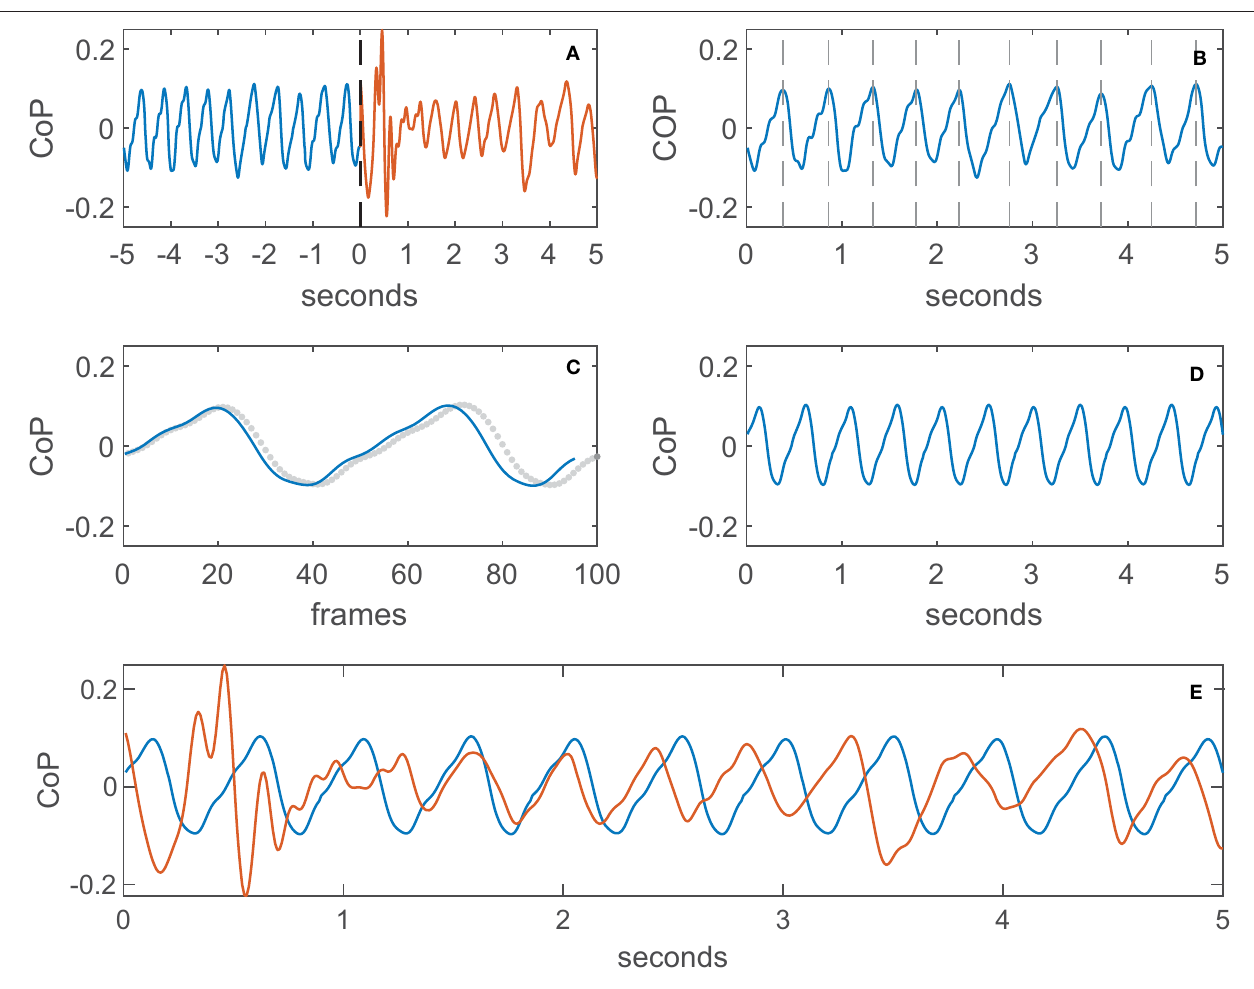
FIGURE 2 | Example calculation of the QRP, (A) : pre- and post-perturbation window (black dashed line is the trigger), (B) : divided into gait cycles, (C) : de-normalization of the gait cycle (dotted line is the normalized gait cycle), (D) : template of unperturbed walking (averaged), (E) : alignment of template (averaged) and perturbed (non-normalized) walking